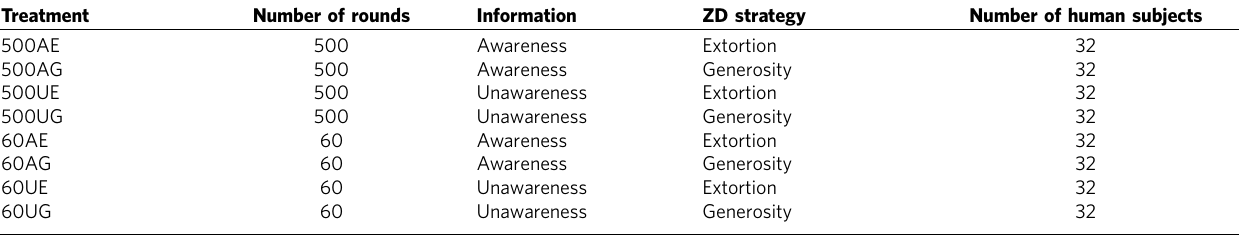
Table 1 | Experimental design.